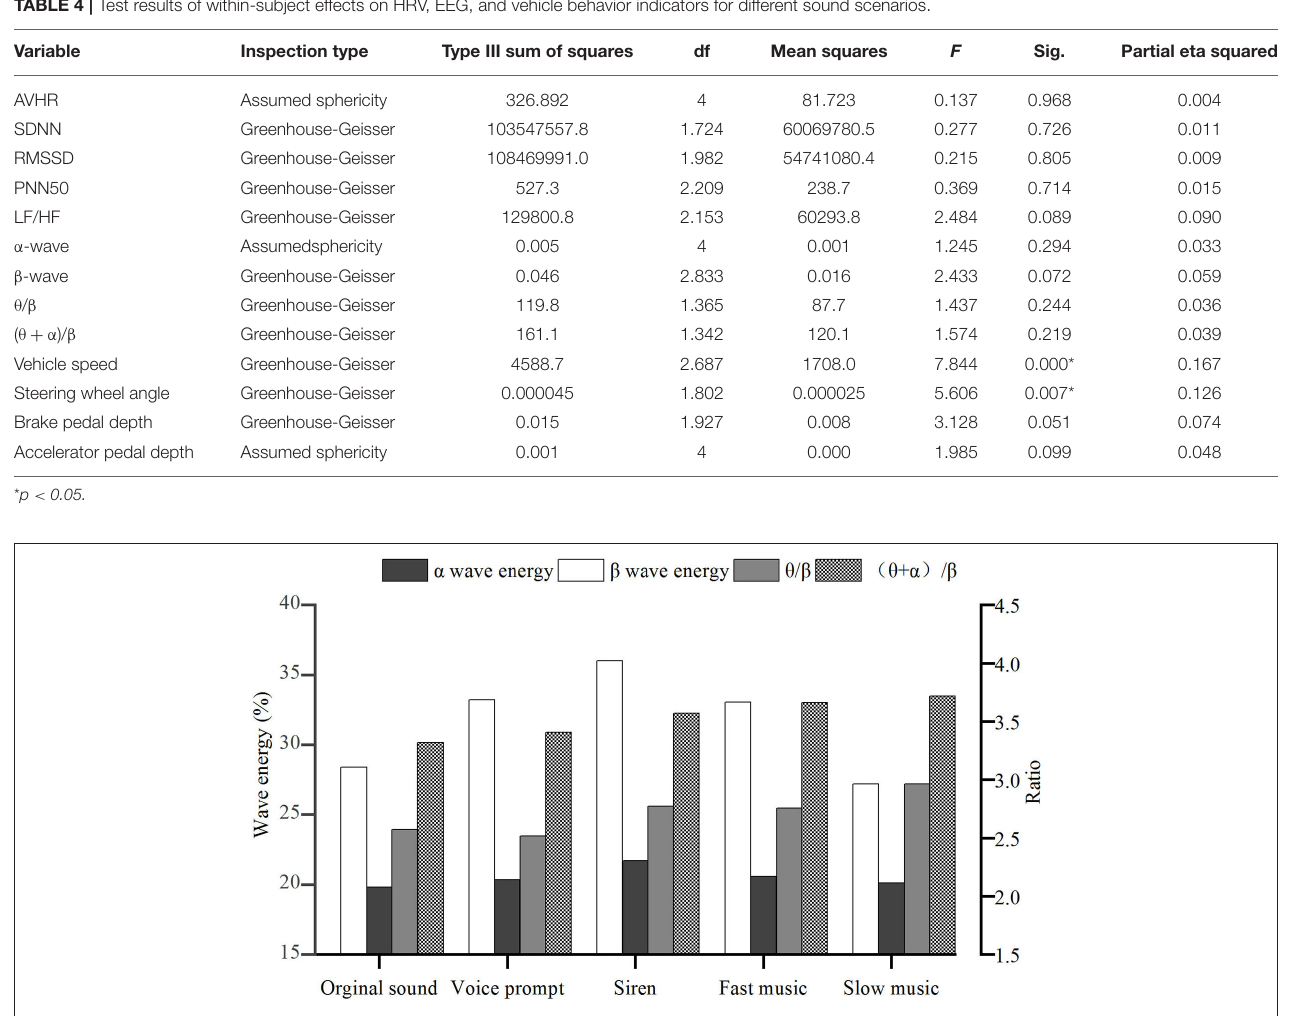
FIGURE 4 | Change of electroencephalogram (EEG) indicators for different sound scenarios.